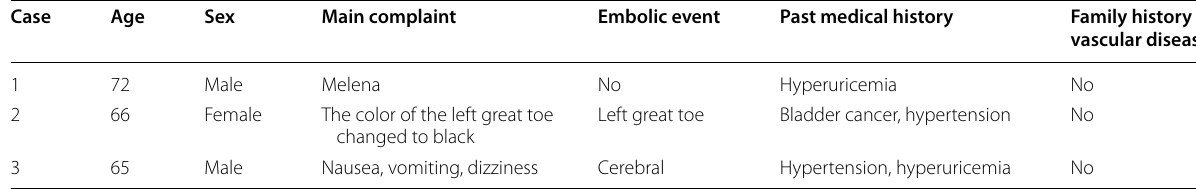
Table 1 Clinical features of the three patients with free-floating thrombi